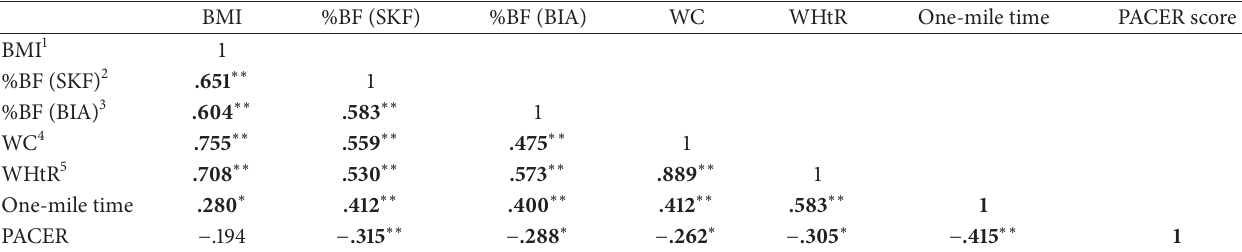
Table 4: Correlation matrix showing anthropometric measures and cardiorespiratory fitness scores for girls.